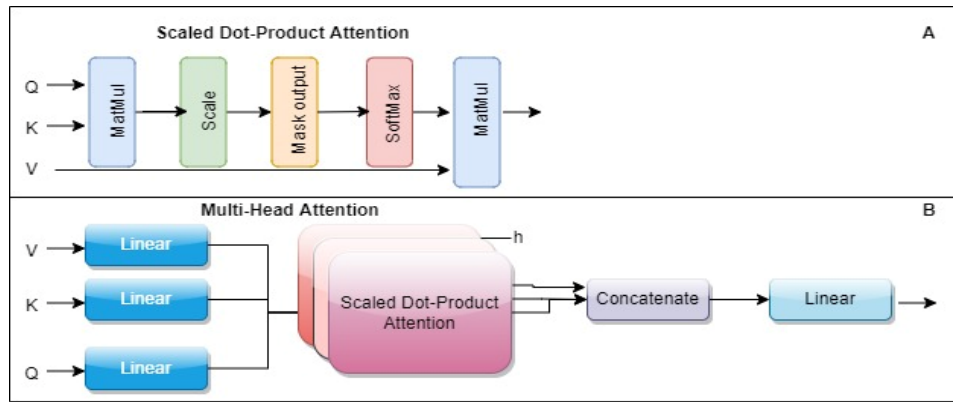
Figure 4. ( A , B ) Attention mechanism in transformer network (This is performed in the multi-head attention mechanism, which concurrently implements several single attention functions by masking the output of the scaled multiplication of the Q and K matrices. The multi-head self-attention is comparable to the encoder’s first sublayer. This multi-head mechanism receives the keys and values from the encoder’s output and the queries from the preceding decoder sublayer on the decoder side. The decoder then focuses on every word in the input sequence).